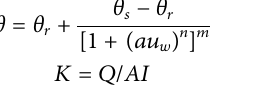
FIGURE 3 | Model calculation framework considering humidity and